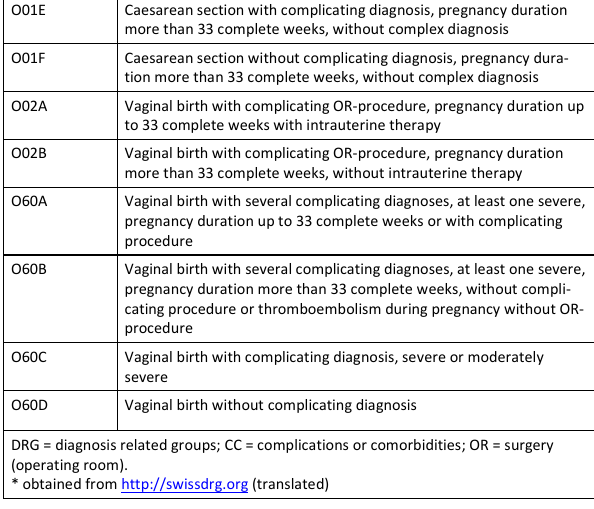
Table S3: Definition of psychiatric medication in Helsana health insurance data (INS); at least one medication was required to classify a woman as receiving psychiatric medica- tion. One supply with a drug with one of the following Anatomical Therapeutic Chemical (ATC) codes *